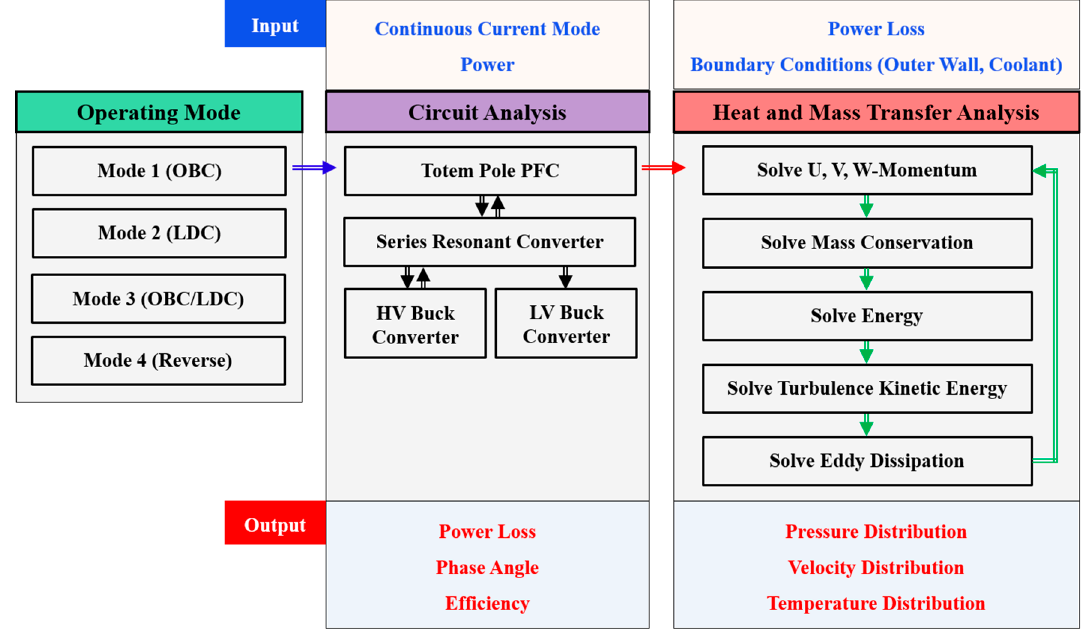
Figure 1. Numerical analysis method used for the 7.2 kW integrated bidirectional onboard battery charger/low-voltage DC–DC converter (OBC/LDC) module developed in this study.